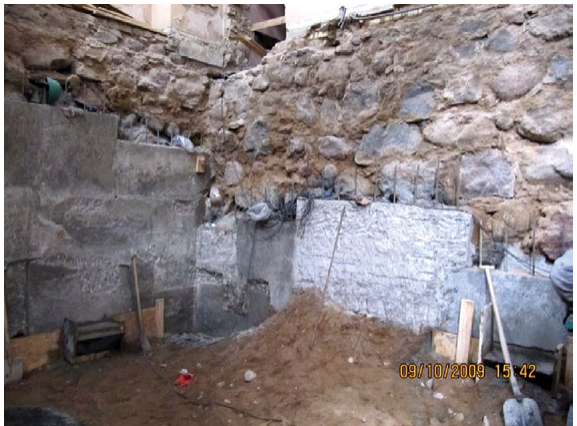
Fig. 6. Madding excavations using a mechanism